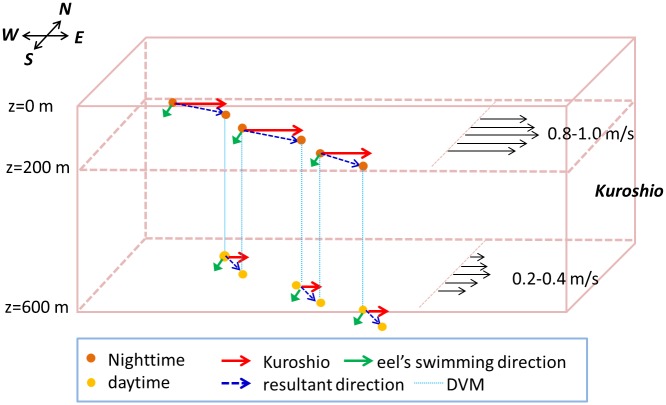
Schematic diagram showing how a v-eel swims across the Kuroshio.Black arrows represent the Kuroshio condition. During nighttime, the v-eel stays near the surface. The eastward strong Kuroshio together with the southward swimming direction of the v-eel leads to an east-south-east movement. The v-eel dives to deeper water during the daytime, where the weaker (than at the surface) Kuroshio and southward swimming results in a southeast migration. A few days later, the v-eel is able to cross the Kuroshio because of the accumulation of southward swimming.